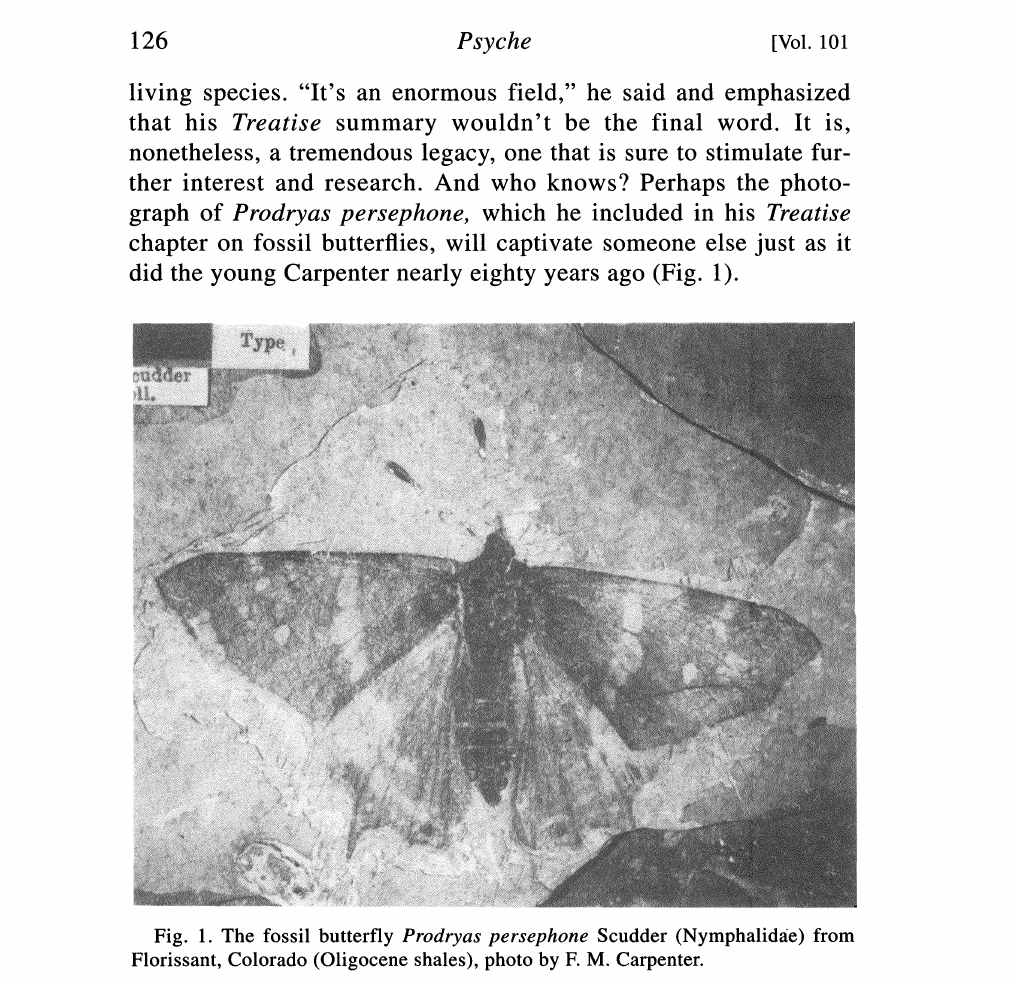
Fig. 1. The fossil butterfly Prodryas persephone Scudder (Nymphalidae) from Florissant, Colorado (Oligocene shales), photo by F. M.